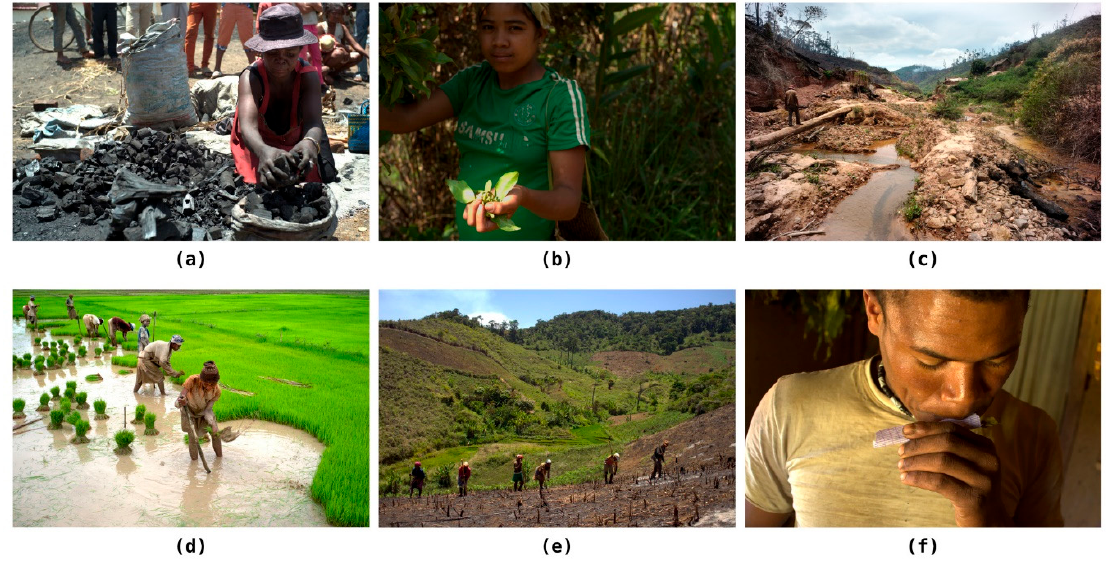
Figure 7. Characteristic land use in the Zahamena socio-ecological system. The ethno-photography in environmental science method (cf. Reference [58]) allows for a shared vision of the landscape uses and proposes a visual characterization of user-defined important livelihood activities surrounding the remaining dense forests: charcoal ( a ), clove cultivation ( b ), artisanal small-scale mining ( c ), rice in flooded paddies ( d ), tavy ( e ), and tobacco ( f ).